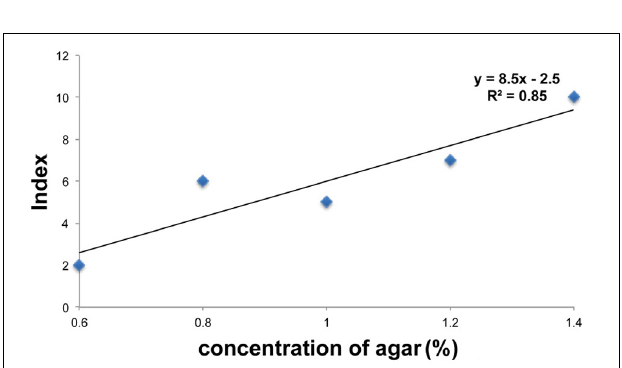
FIGURE 4 | Level of starch digestion 17h after larval application. The rate of starch digestion was examined by changing the concentration of agar used in the ISAM from 0.6 to 1.4% at 0.2% intervals. Twenty larvae were applied simultaneously to each gel. The color of gel pieces faded more rapidly with harder gels. The change in gel color at 17h after larvae application was photographed and the color fading was compared with that in Figure 1 . The value of the color index corresponding to the same gel color (the same level of color fading) was chosen to evaluate the relative amount of amylase in each gel.